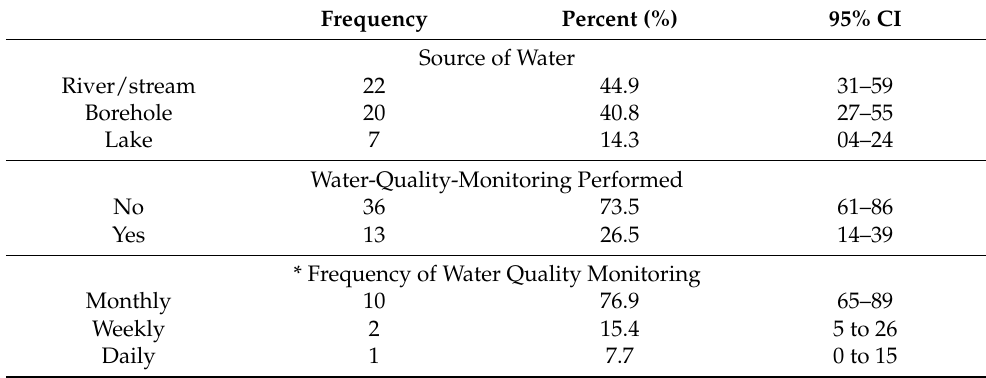
Table 2. Water sources and water-quality-monitoring trends.